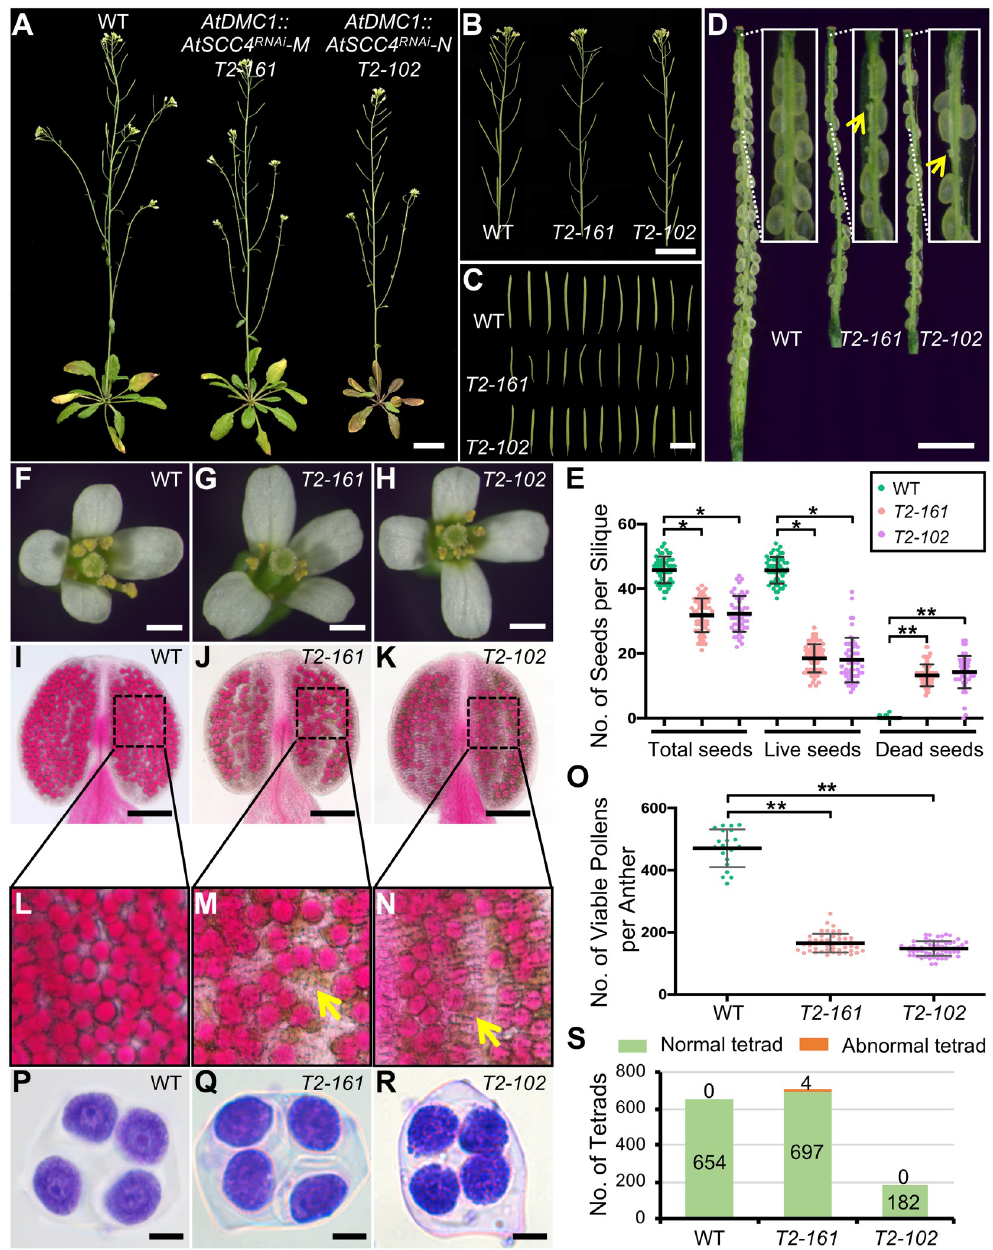
Fig 6. AtDMC1 :: AtSCC4 RNAi transgenic plants have reduced fertility. (A) WT, AtDMC1 :: AtSCC4 RNAi -M T2-161 and AtDMC1 :: AtSCC4 RNAi -N T2-102 (M and N refer the fragments used for the construction of RNAi plasmids) plants. Bar = 3 cm. (B) Primary stems of WT, T2-161 and T2-102 . Bar = 3 cm. (C) Siliques of WT, T2-161 and T2-102 . Bar = 1 cm. (D) Stripped siliques of WT, T2-161 and T2-102 . Yellow arrows indicate undeveloped embryos. Bar = 1 mm. (E) Plots of total seeds, live seeds and dead seeds in WT, T2-161 and T2-102 ( � P < 0.05 or �� P < 0.01, the significance of reduced seed number in AtSCC4 RNAi transgenic plants versus WT, by two-tailed Student’s t test; each dot represents the number of seeds in one silique). (F-H) Open flowers of WT, T2-161 and T2-102 . Bar = 1 mm. (I-K) Alexander staining of WT, T2-161 and T2-102 anthers. Bar = 100 μ m. (L-N) Zoom-in of WT, T2-161 and T2-102 pollens. (O) Plots of viable pollen in WT, T2-161 and T2-102 ( �� P < 0.01, the significance of reduced pollen number in AtSCC4 RNAi transgenic plants versus WT, by two- tailed Student’s t test; each dot represents the number of pollen in one anther). (P-Q) Toluidine blue dye staining of WT, T2- 161 and T2-102 tetrad-stage microspores. Bar = 100 μ m. (S) Plots of normal and abnormal tetrad-stage microspores in WT, T2-161 and T2-102